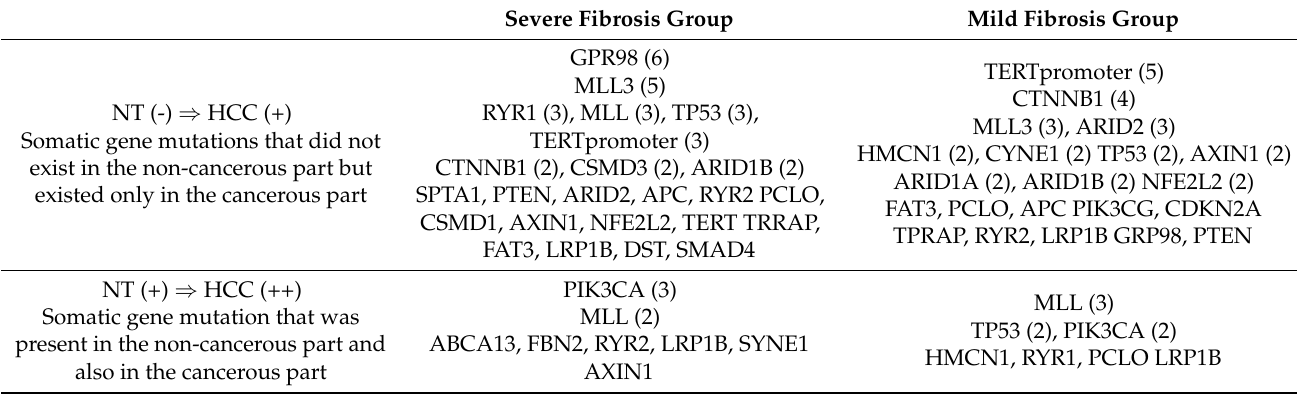
Table 2. Detection of somatic mutations in cancerous and non-cancerous areas by a next-generation sequencer (NGS). Severe Fibrosis